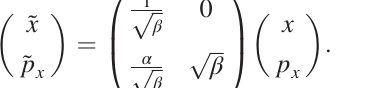
FIG. 5. Fitting coupling ratio ( r ≡ to obtain the coupling resonance strength coefficient G